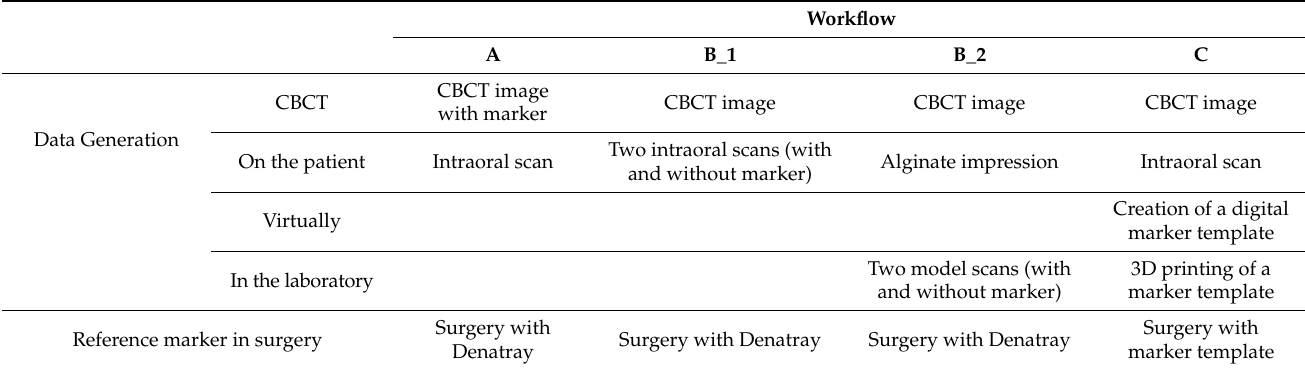
Table 1. Overview of the four different process